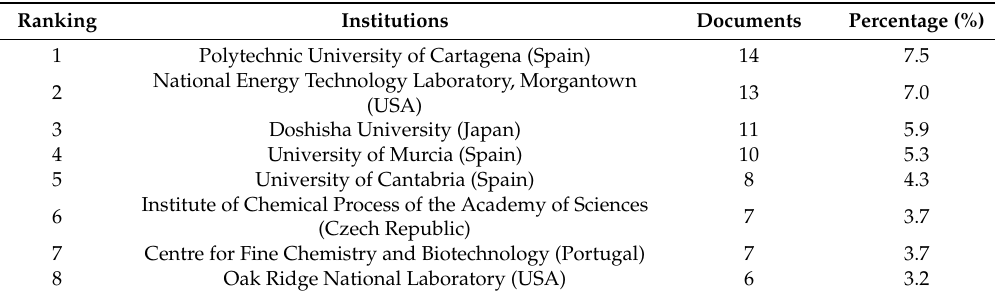
Table 4. The top 8 most productive